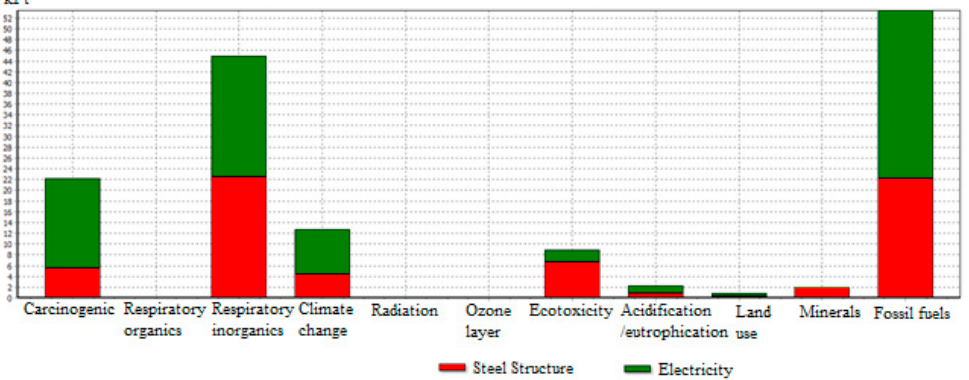
Figure 10. Single score comparison of processes related to the production and utilization of the steel structure and the production of electricity using Eco-Indicator 99 methodology.